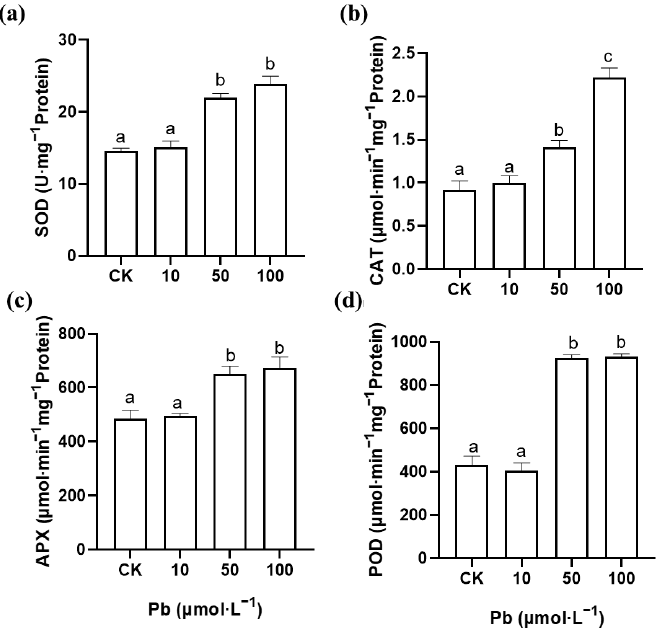
Figure 6. Activity of SOD ( a ), CAT ( b ), APX ( c ) and POD ( d ) in roots of M. cordata grown hydropon- ically under control (CK) and varied concentrations of Pb for seven days. Values are means ± SE ( n = 3) with three separate replicates. Means denoted by different letters refer to the significant differences ( p < 0.05, Duncan’s test).